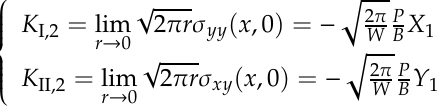
Figure 17. The boundary conditions.